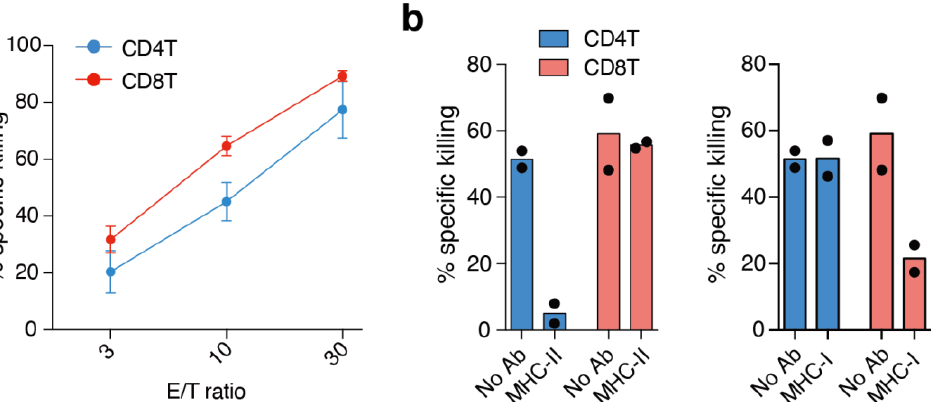
Figure 2. Activated CD4 + T cells and CD8 + T cells showed MHC-dependent cytotoxicity against lymphoma cells. ( a ) Naïve CD4 + T cells and CD8 + T cells were independently co-cultured with iCL for 24–31 days, as shown in Figure 1a. T cells were isolated and tested for killing activity by indicated E/T ratios. Mean +/ − SD from two to eight biological replicates are shown on both CD4 + and CD8 + T cells. ( b ) In vitro-expanded CD4 + and CD8 + T cells from GCB-LMP1/2 mice were tested for MHC-dependency of killing activity at 30 E/T ratios in the presence or absence of MHC-I (H2K/H2D) or MHC-II (I-A/I-E) blocking antibodies (n = 2). ( a , b ) Representative data of more than two independent experiments are shown.